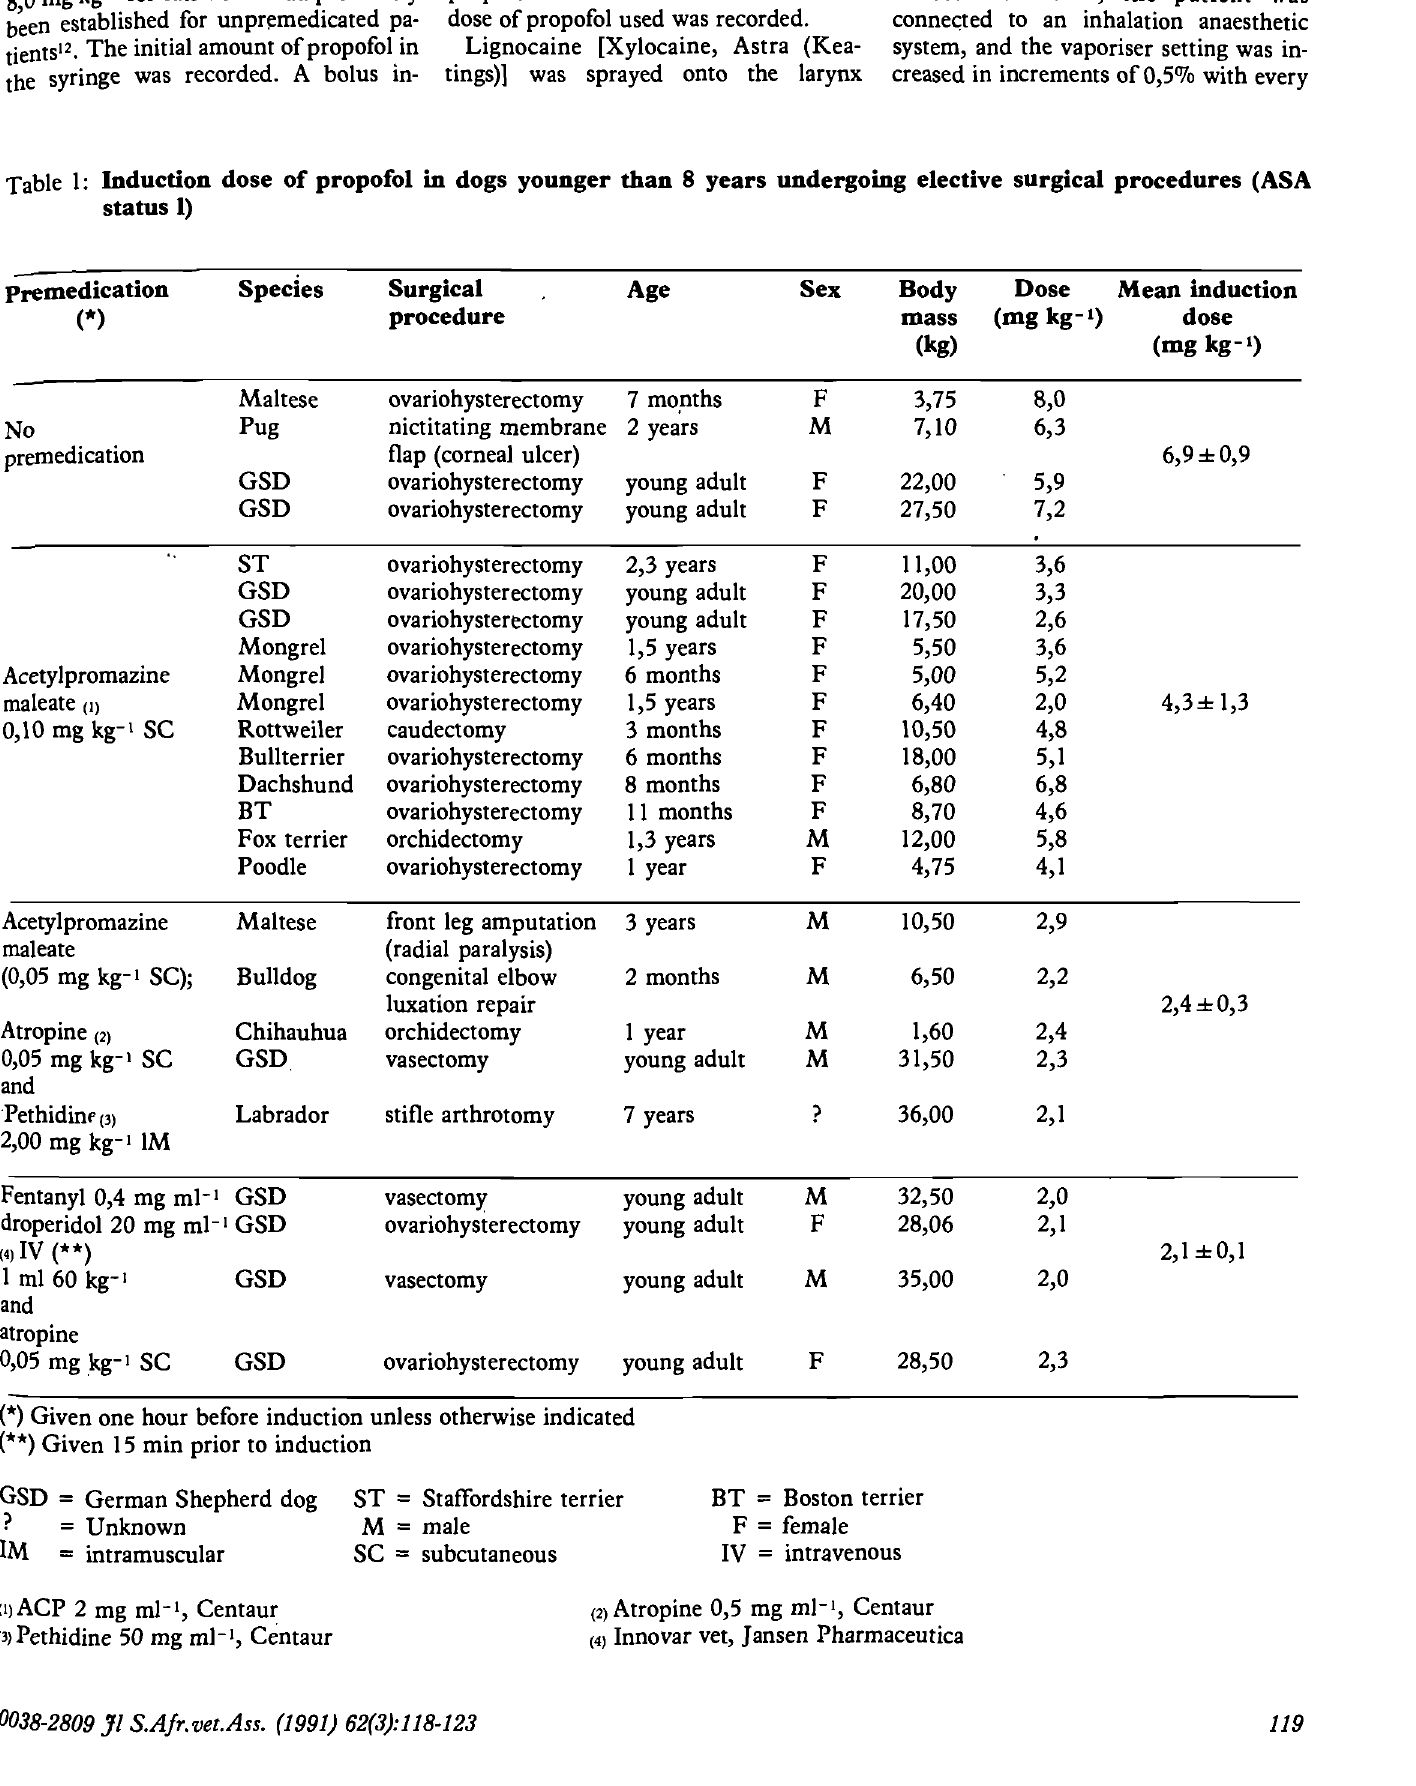
Table I: Induction dose of propofol in dogs younger than 8 years undergoing elective surgical procedures (ASA status